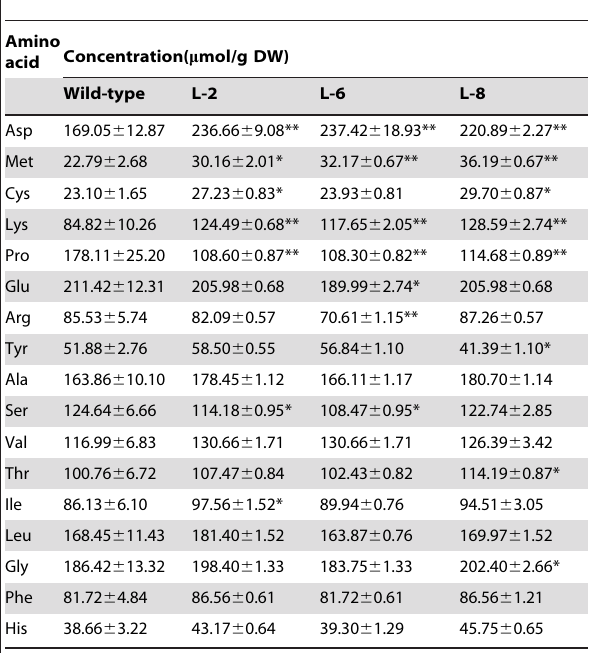
The data are presented as the means 6 SE obtained from three independent measurements. * represents statistically significant differences (P , 0.05). ** represents statistically significant differences (P , 0.01). The amounts of amino acids were calculated from dry weight of samples as detected and are given in m mol/g of dry weight (DW) of leaves samples. The total amino acid content did not differ significantly between wild-type and transgenic lines. Three plantlets of each type were analyzed.